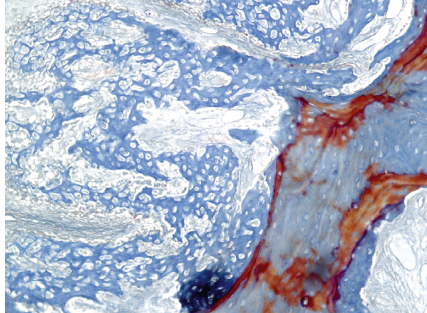
Figure 7: Histotopogram of the rabbit’s mandible cross section 2 weeks after the formation of a bone defect and introduction of a suspension of calcium hydroxide with nanodispersed cerium